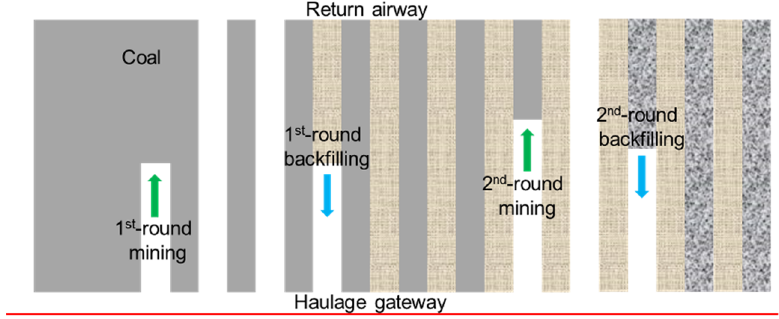
Figure 5. Schematic illustration of backfilling methodology in a continuous mining face (drawing designed by Xiaowei